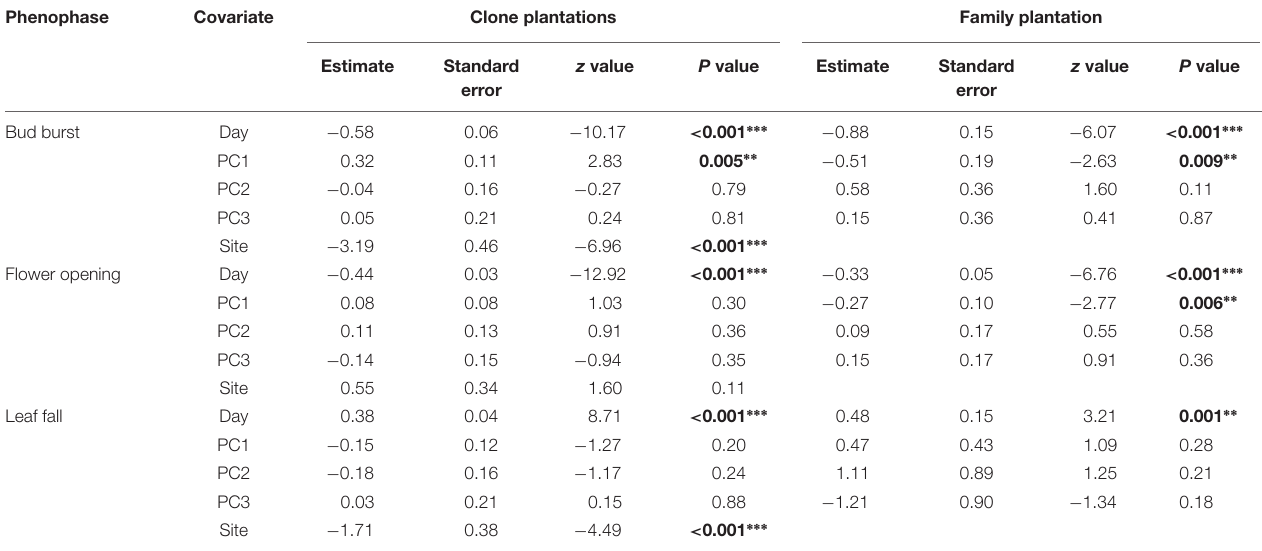
TABLE 7 | Model statistics for the phenological response variables in the clone plantations and the family plantation including morphological covariates in the fixed parts of the models. Phenophase Covariate Clone